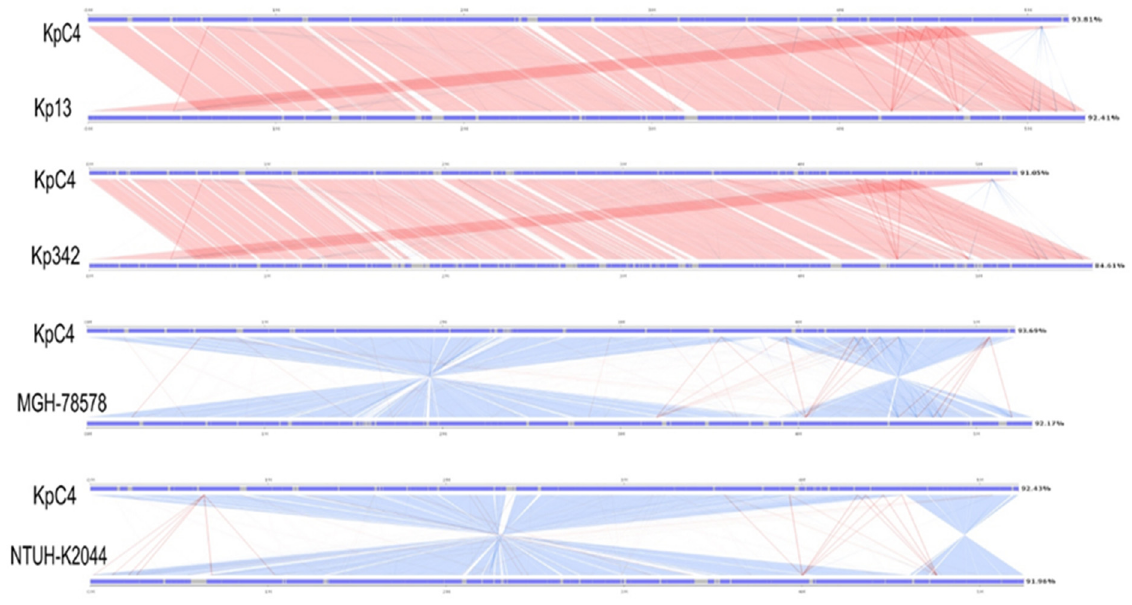
Figure 7. Comparative analysis of genome structures between KpC4 and the reference strains Kp13, Kv342, MGH 78578, and NTUH-K2044.